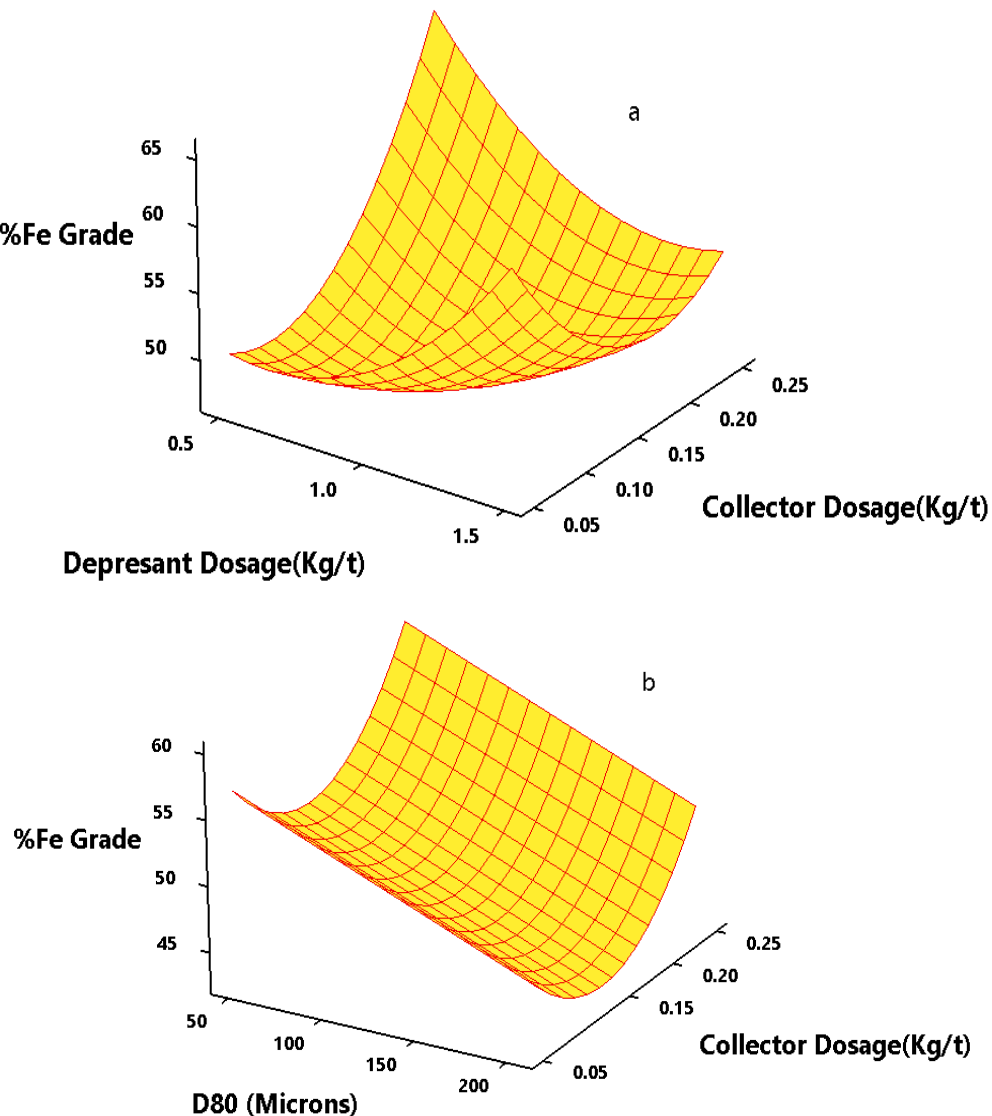
Figure 5. ( a ) Effect of collector and depressant dosages on the grade of concentrate. ( b ) Effect of D80 and collector dosages on the grade of concentrate.